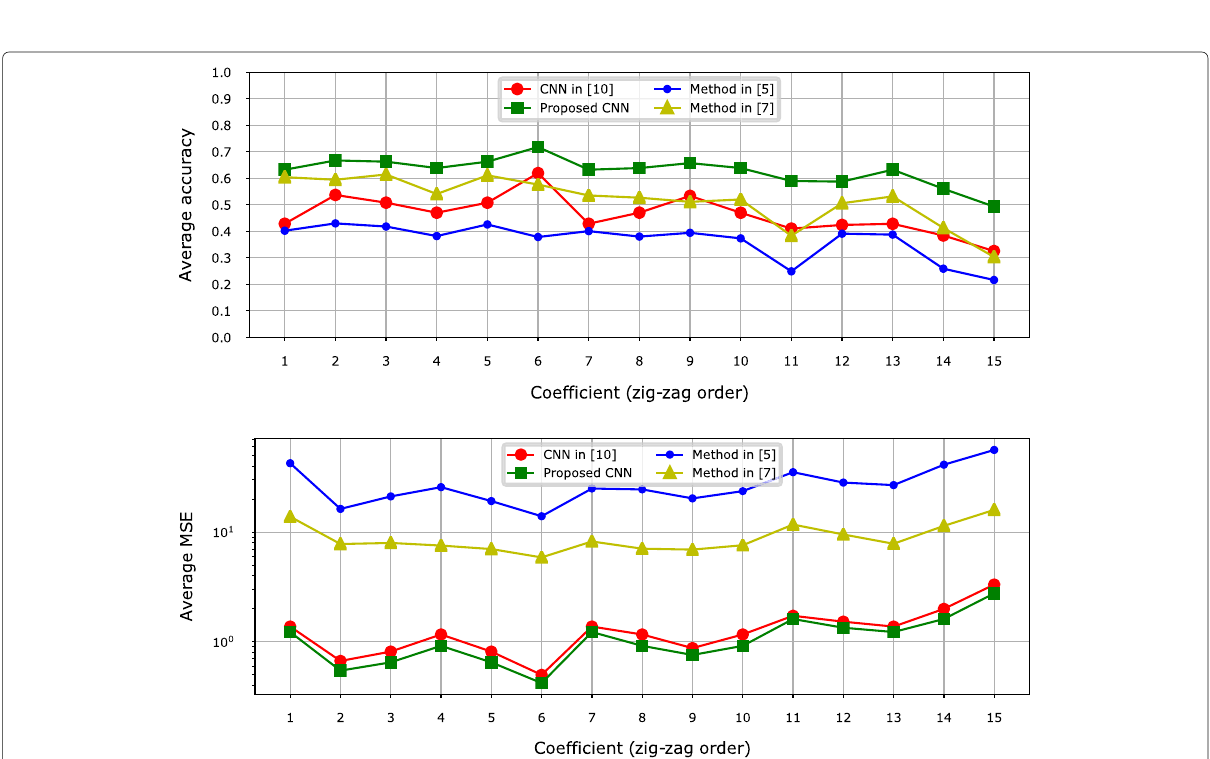
Fig. 4 Average accuracy (top) and average MSE (bottom) of the estimation for each of the 15 DCT coefficients, for QF 2 = 90, in aligned DJPEG